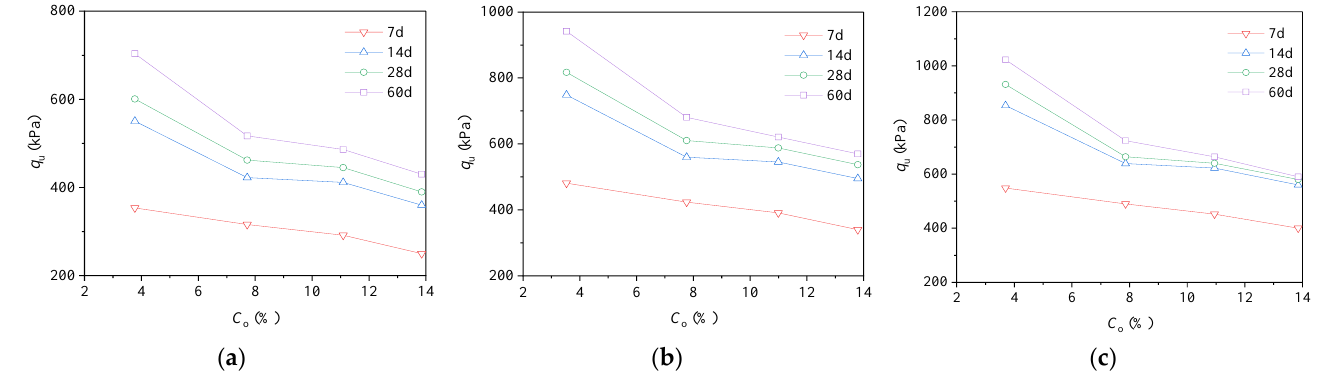
Figure 3. Relationship of q u - C o at different temperatures : ( a ) T = 18 °C ; ( b ) T = 36 °C ; ( c ) T = 46 °C .